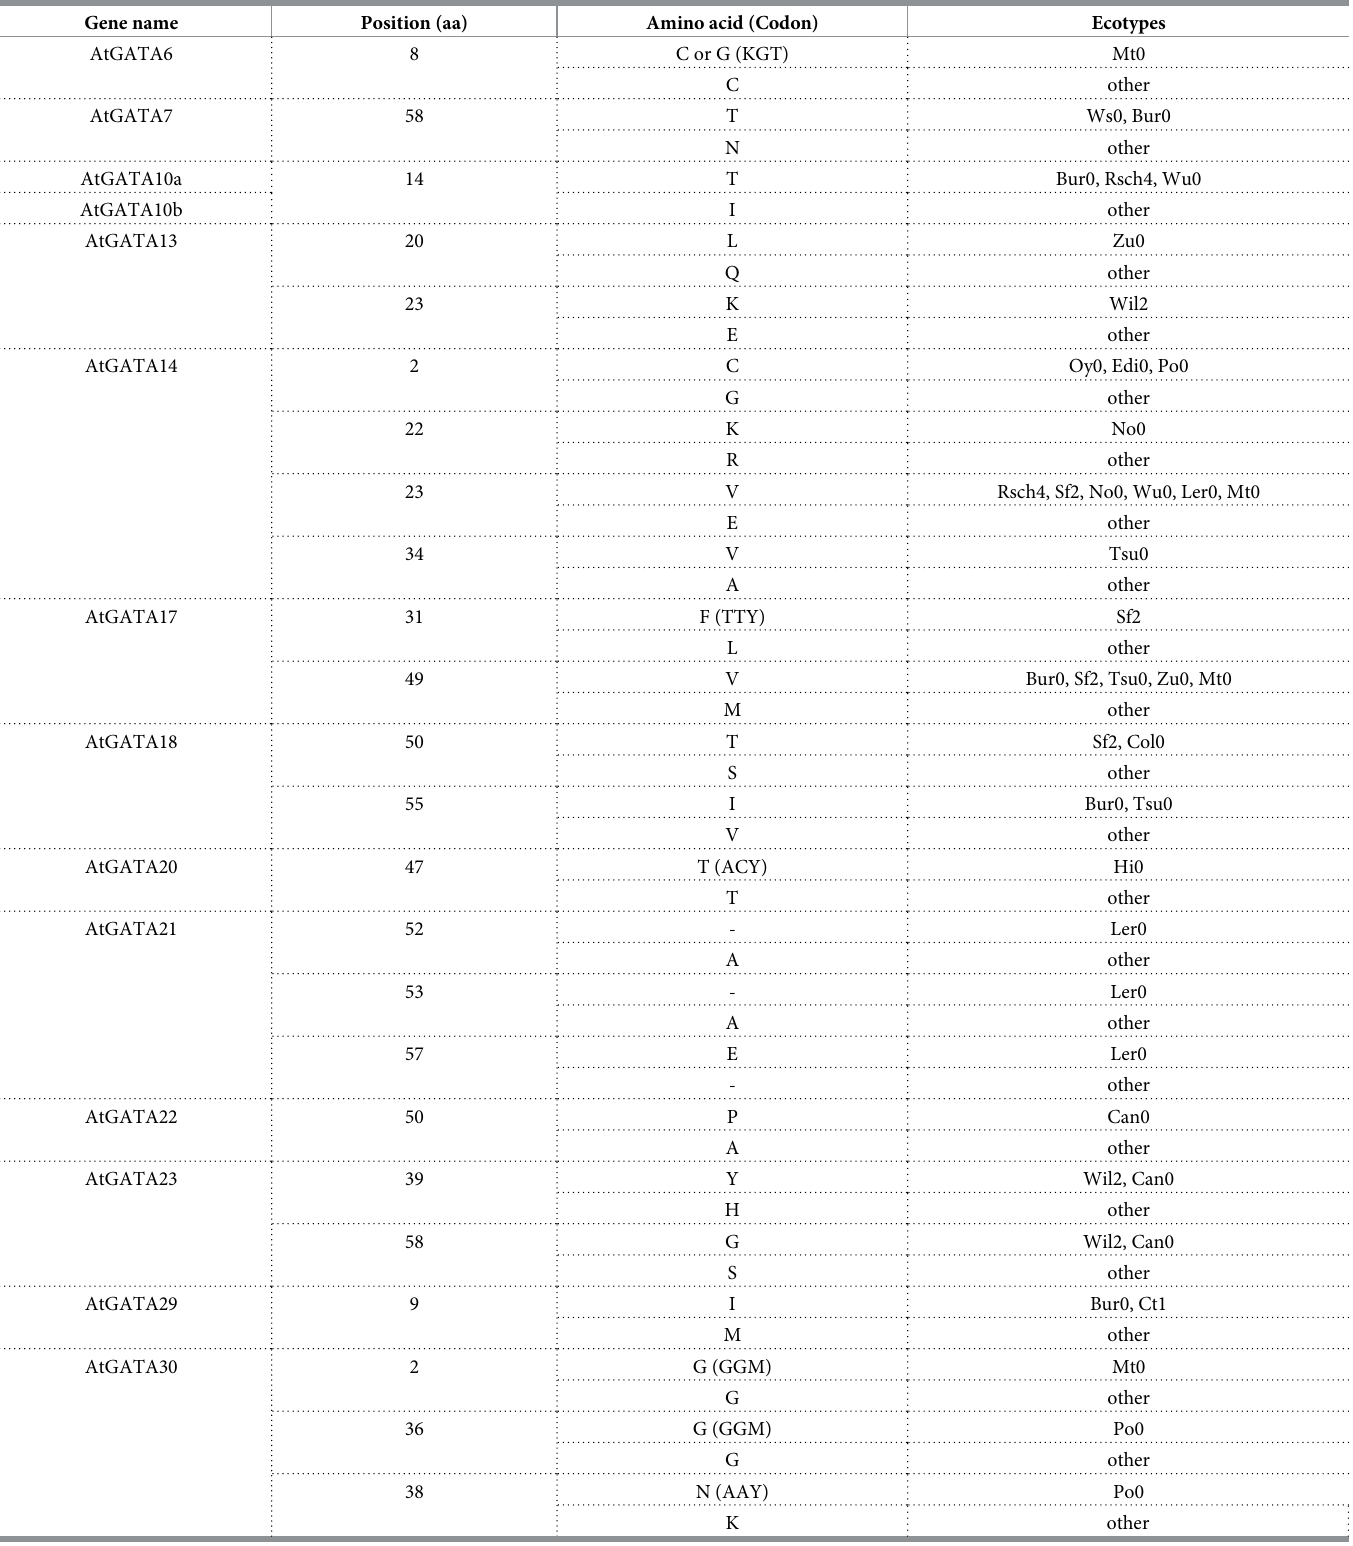
Table 6. List of variable amino acids found in GATA domains of A . thaliana GATA TFs. Gene